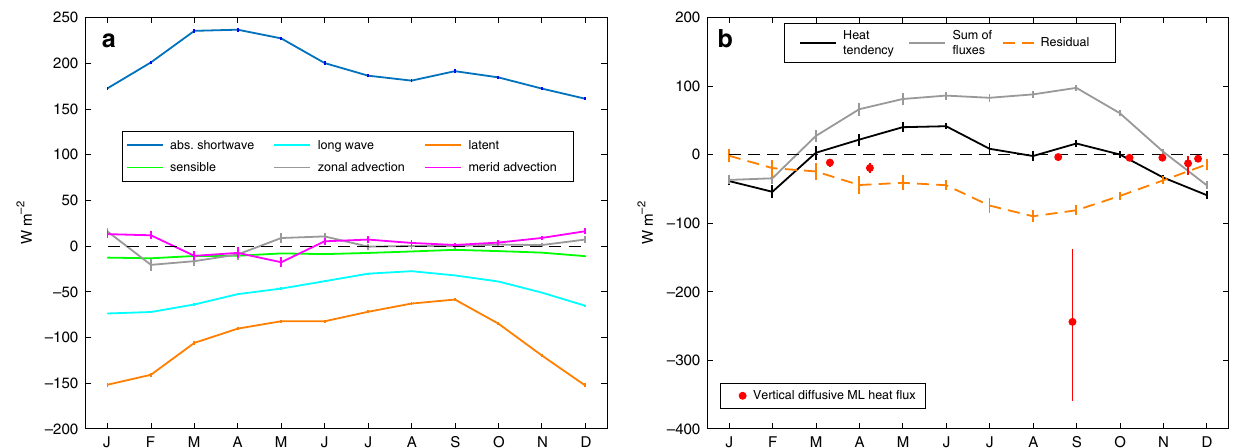
Fig. 2 Seasonal mixed layer heat budget at 11.5°N, 23°W. a Seasonal cycle of the individual contributions to the mixed layer (ML) heat budget as indicated in the legend. b Heat tendency (black) and the sum of the individual heat budget contributions (gray; sum of fl uxes) as shown in a . The residual of these two terms is shown by the dashed orange line. Red dots indicate the vertical diffusive ML heat fl ux estimates from microstructure observations of the eight existing realizations at this location (vertical red lines denote the 95% con fi dence limits). Error estimates for the individual ePIRATA terms and the residual are calculated as explained in the “ Methods ” section. Note that the ticks on the x -axis correspond to the middle of the